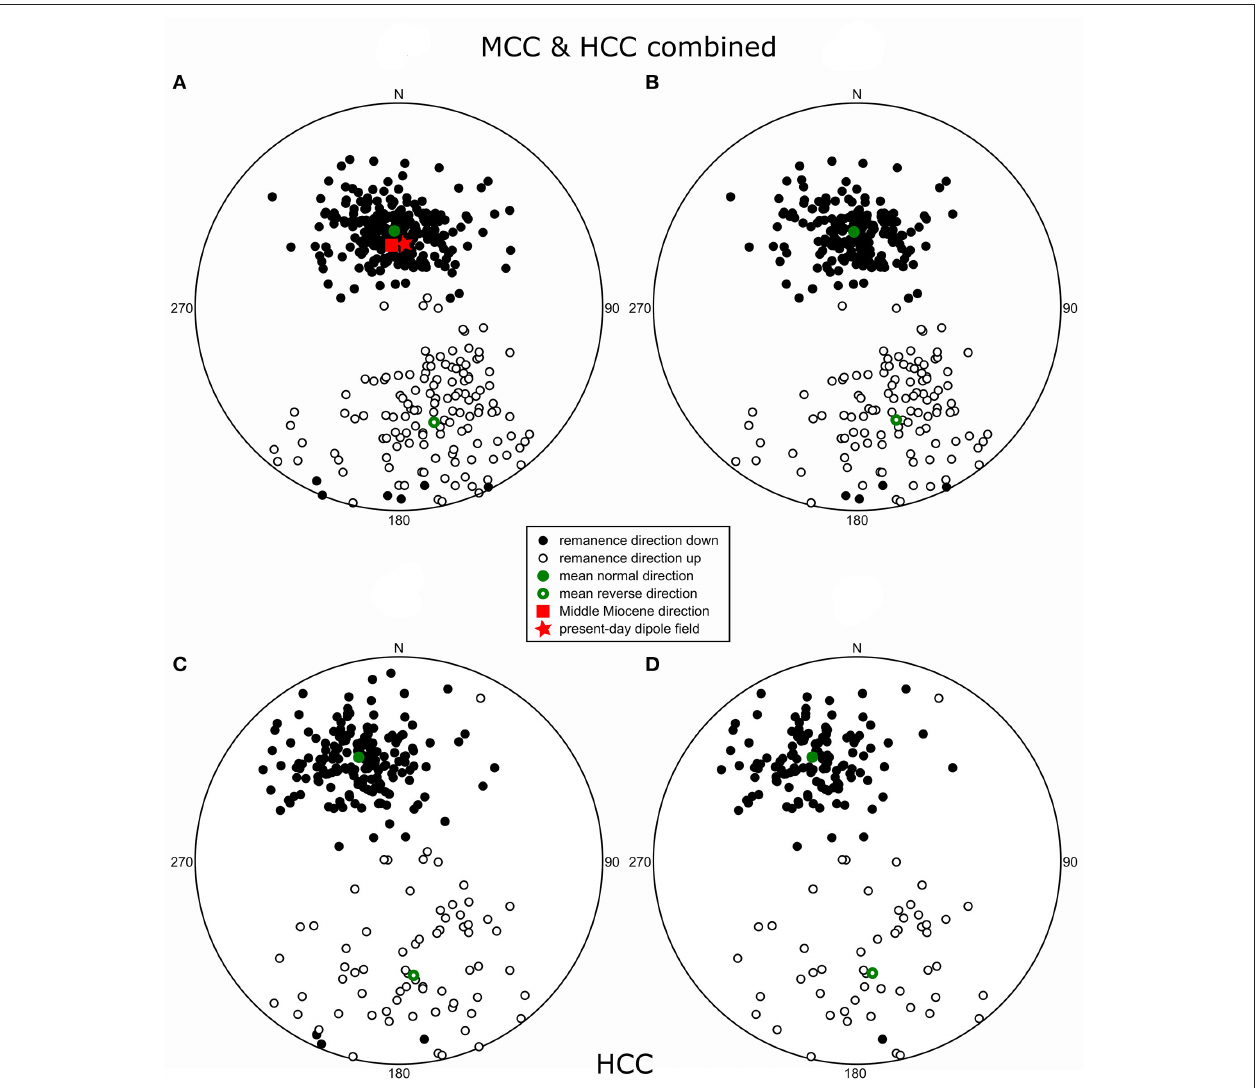
FIGURE 12 | Equal area projection of remanence directions (in stratigraphic coordinates) determined from demagnetization of NRM (mean directions of normal and reverse polarities are indicated by green circles): (A) directions from the MCC & HCC combined data set as shown in Figure 4C with expected Middle Miocene (red square) and present-day (red star) Earth magnetic field directions; (B) MCC & HCC combined data retained after rock magnetic selection (used for the final magnetostratigraphy; see Figure 13E ); (C) HCC directions only and (D) HCC directions filtered by the same rock magnetic